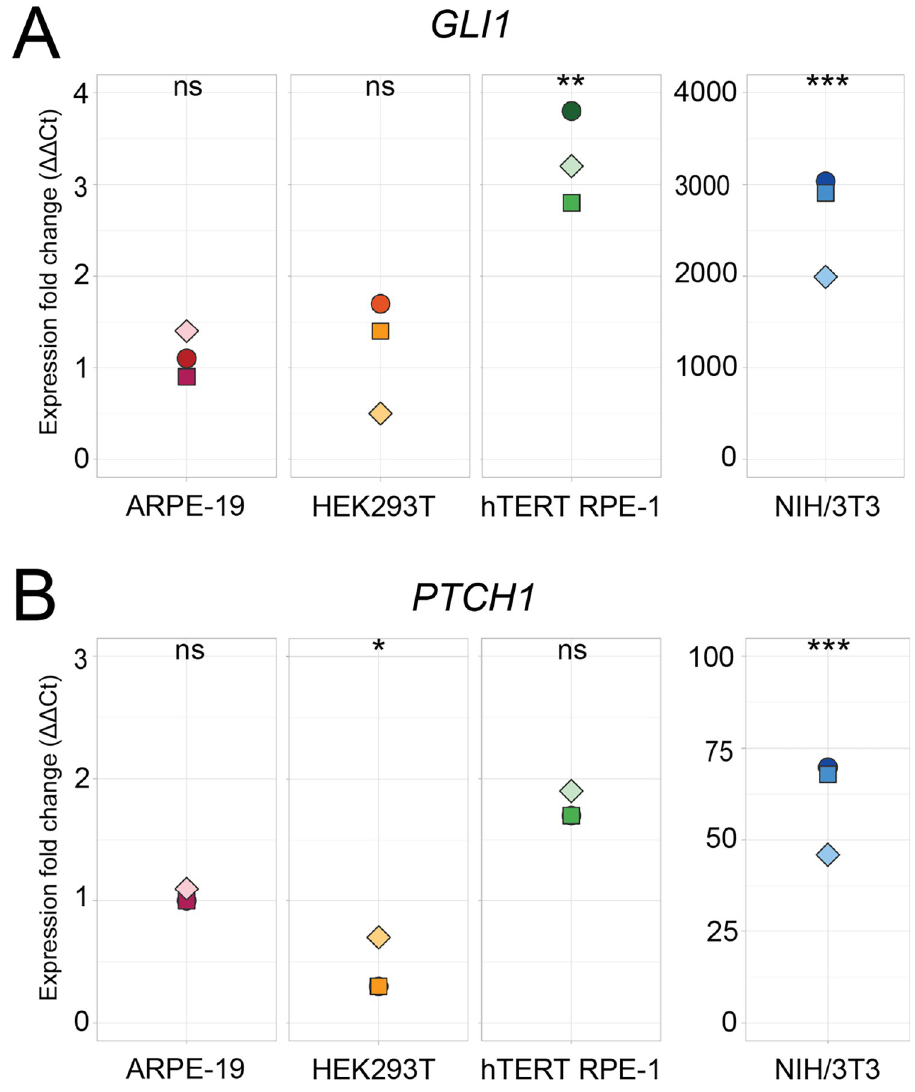
Fig 3. GLI1 and PTCH1 expression in response to Hh pathway stimulation. A) GLI1 and B) PTCH1 target gene induction. Each data point represents the expression fold change of stimulated cells from the same batch. Expression fold change was normalized to unstimulated values, which were set to 1. Two-tailed Student’s t- test was performed. P - values represented significant differences if they ranged from 0.01 to 0.05 ( � ), 0.001 to 0.01 ( �� ), and < 0.001 ( ��� ).